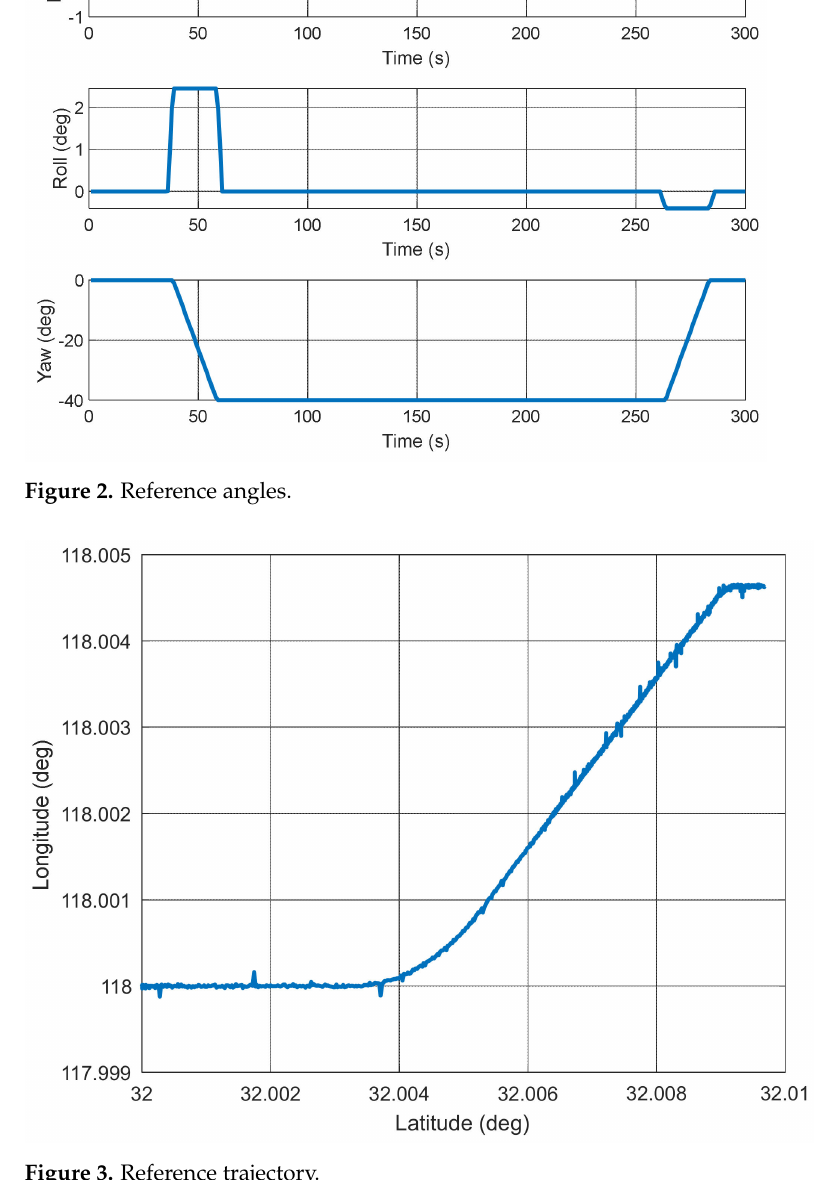
Figure 3. Reference trajectory. Table 2. Parameter setting of inertial measurement